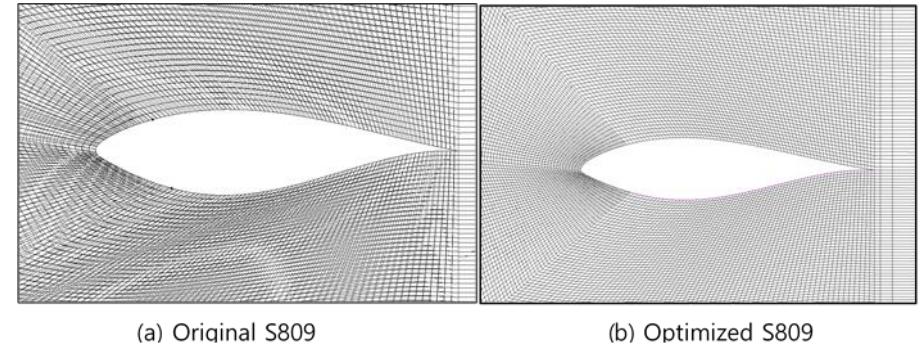
Figure 7. Mesh distribution of the airfoil at AOA = 6.2°.